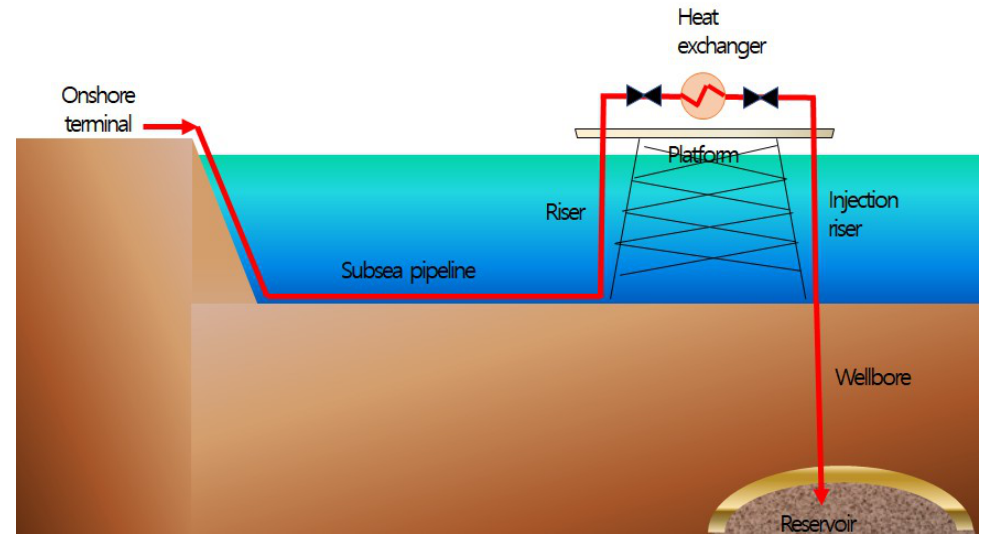
Figure 3. Schematic of the offshore CO 2 transportation and injection system.